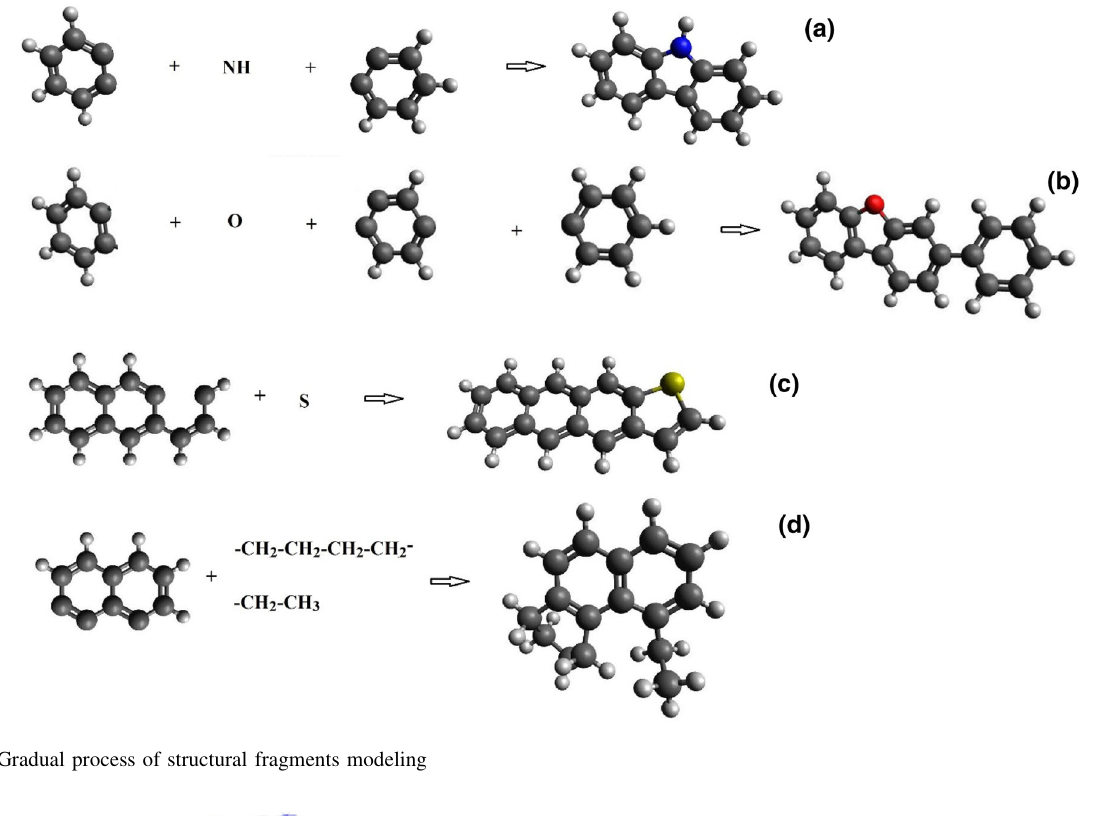
Fig. 1 Gradual process of structural fragments modeling